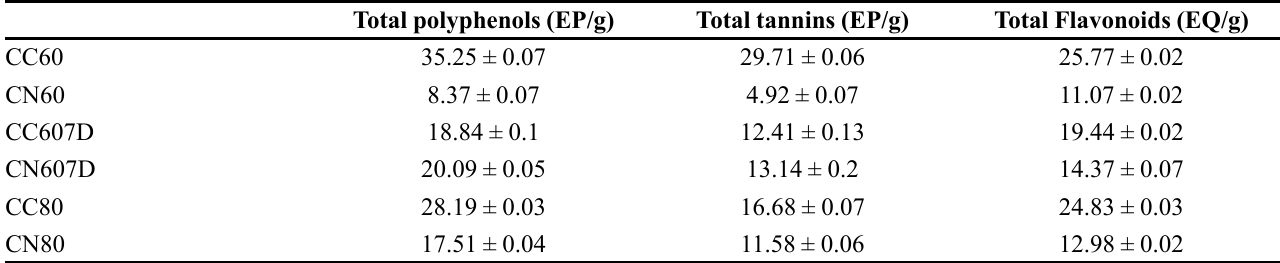
Values expressed as mean ± standard deviation obtained with triplicates. Results of total polyphenols and total tannins expressed as pyrogallol equivalent mg/g extract (EP/g) and total flavonoids as quercetin equivalent mg/g extract